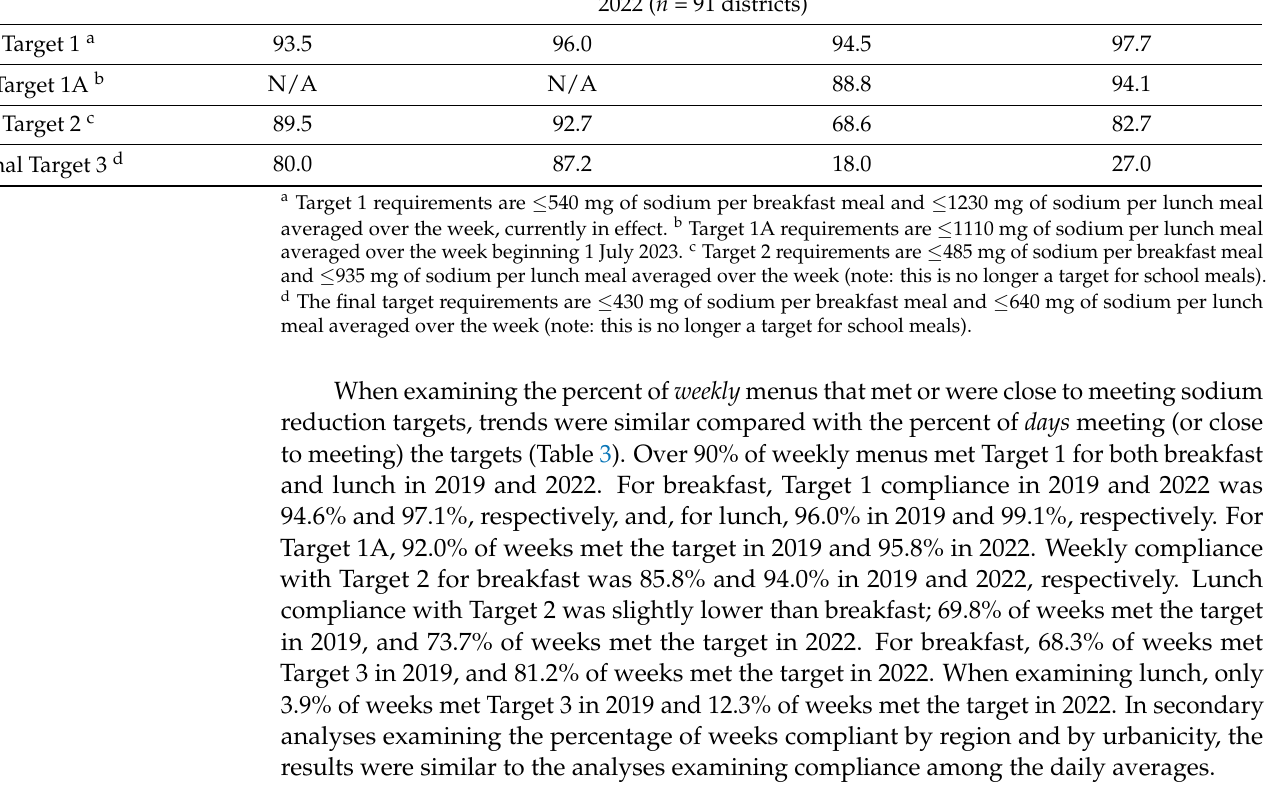
Table 3. Percent of weekly menus a that met or were close to meeting sodium reduction targets in